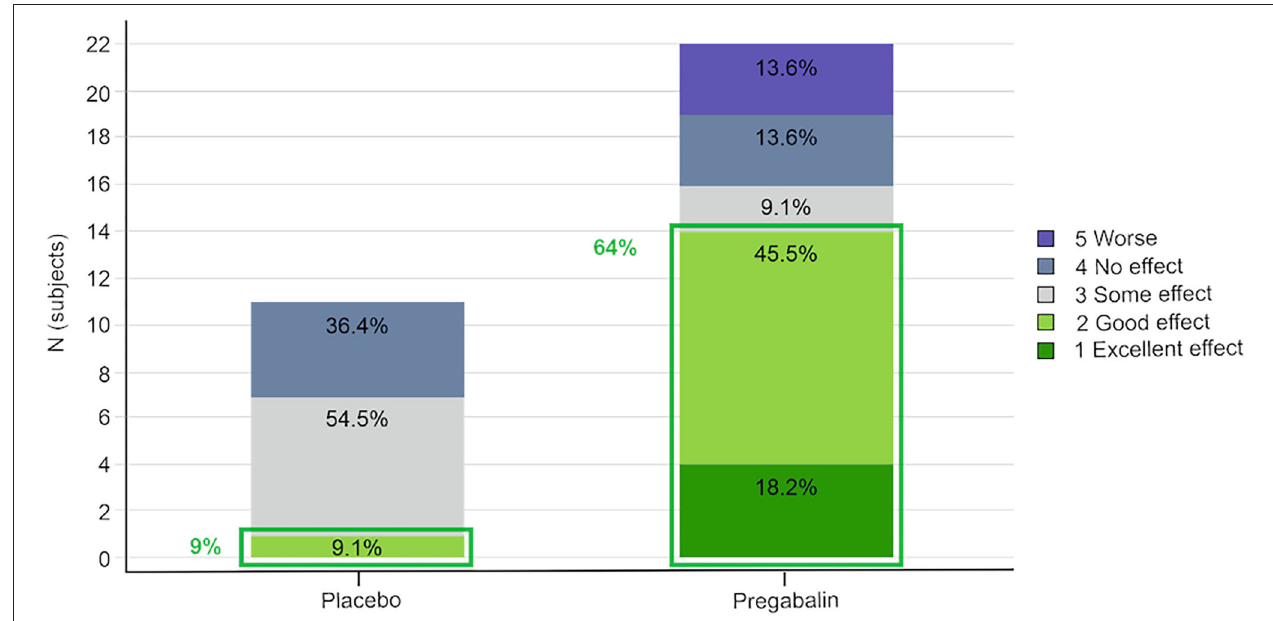
FIGURE 2 | Owner’s assessment of the effect of the study treatment. Pregabalin 5 and 10 mg/kg groups